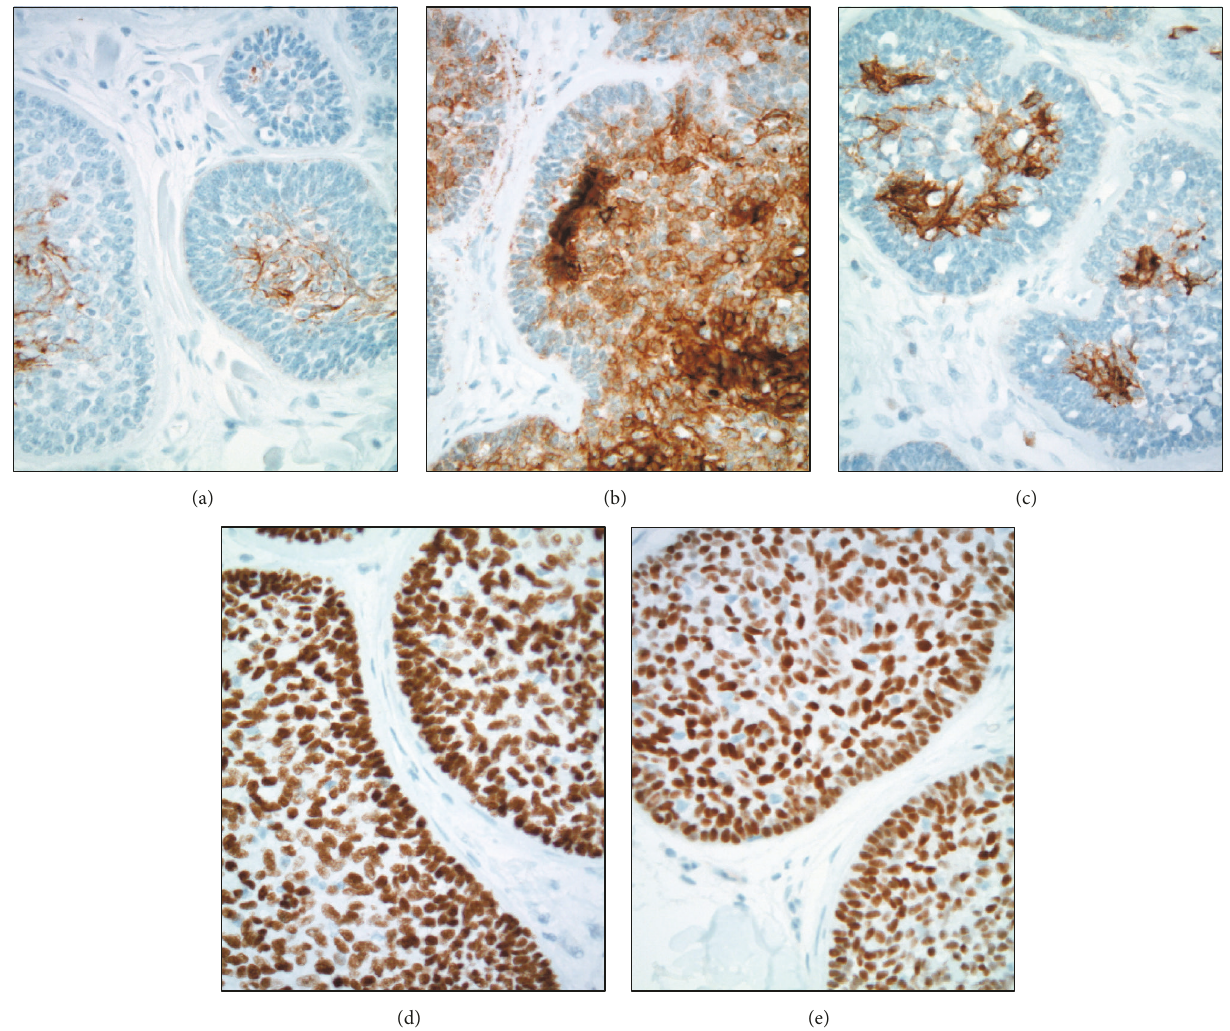
Figure 4: High magnification immunohistochemistry of selected cutaneous basaloid tumor markers: (a) focal membranous and cytoplasmic positivity in center of tumor cell nests with sparing of outer cells, CKAE1/3, 400x; (b) diffuse and strong cytoplasmic positivity in center of tumor cell nests with comparative sparing of myoepithelial-like edges, CK5/6, 400x; (c) patchy cytoplasmic and membranous positivity in center of tumor cell nests with sparing of outer cells, CK7, 400x; (d) diffuse and strong nuclear positivity throughout tumor cell nests, p63, 400x; (e) diffuse nuclear positivity of moderate to strong intensity throughout tumor cell nests, SOX10,